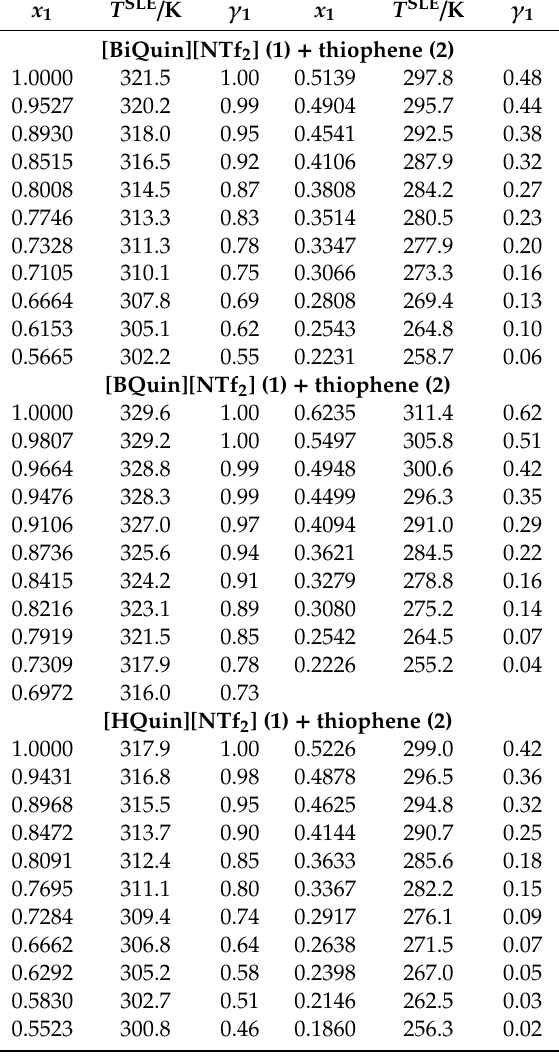
Table 1. Experimental (solid + liquid) phase equilibrium data, SLE, for {IL (1) + thiophene (2)}